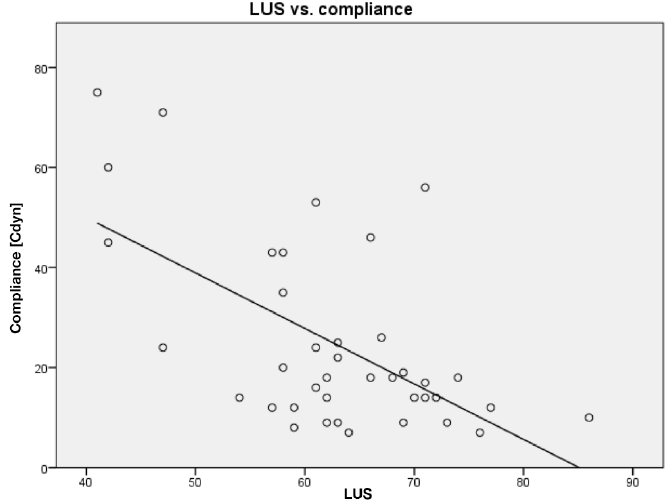
Figure 5. LUS score compared to compliance. Line of best fit is shown as a solid line. Table 3. Findings in 10 patients included. Start and end define first and last day of scan. End for “Survivor” group is before weaning from VV-ECMO, for “On ECMO” group at last day of study and for “Non-survivor” group before death.